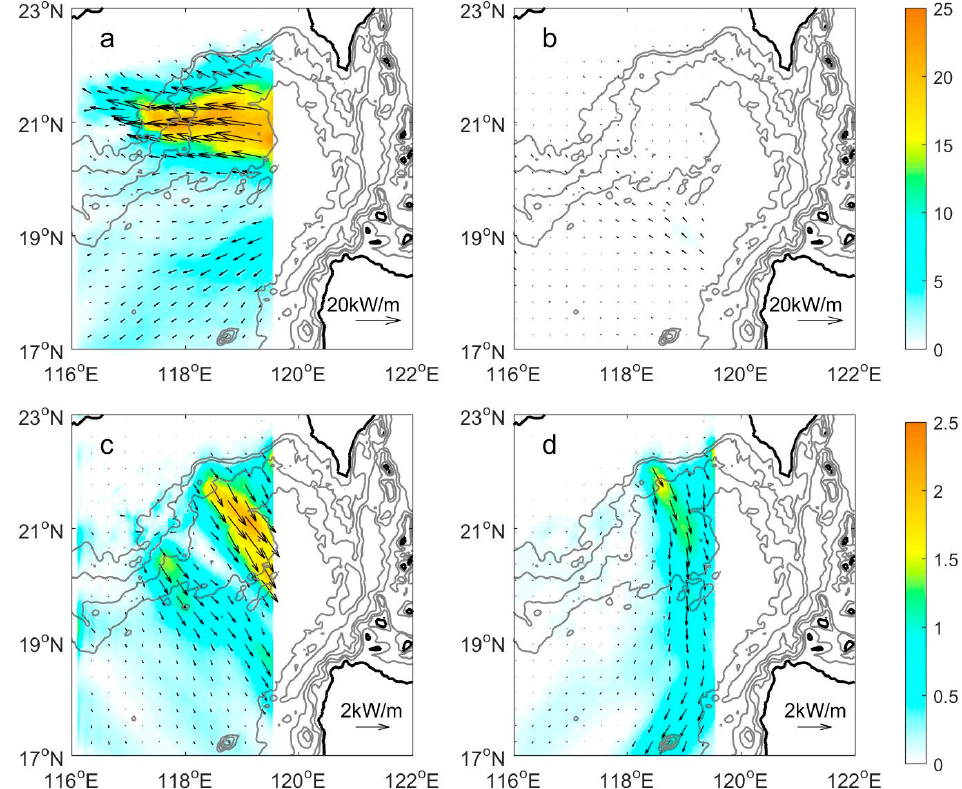
Figure 5. Depth integrated energy flux of the ( a , b ) westward, and ( c , d ) southward components in ( a , c ) the Full case and ( b , c ) the Slope case. The shadings indicate the magnitude (unit: kW/m) and the arrows show the directions. The gray lines indicate isobathic contours of − 3000, − 2000, − 1000, and − 500 m.